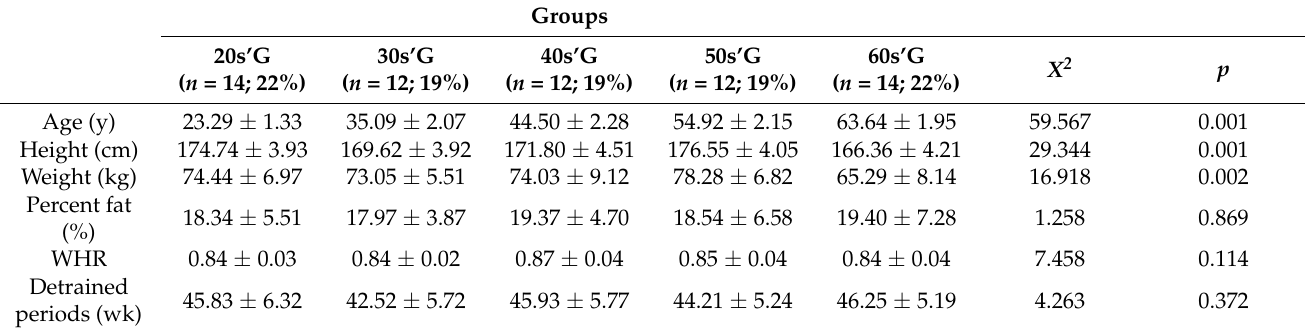
Table 1. Physical characteristics of the participants before